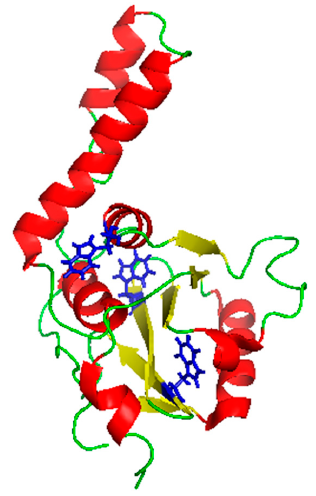
Figure 1. Ribbon representation of the JD structure. The Protein Data Bank accession code for the structure is 1ZYB with tryptophan residues highlighted in blue. The figure was prepared with PyMOL. Red: Helices; yellow: beta-strands; green: disordered stretches.